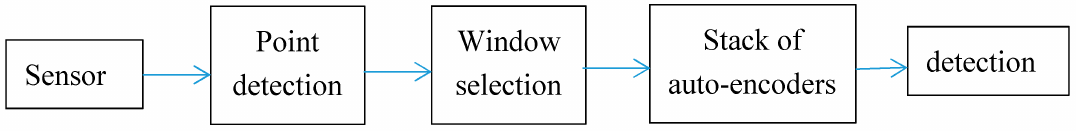
Figure 2. Movement detection.